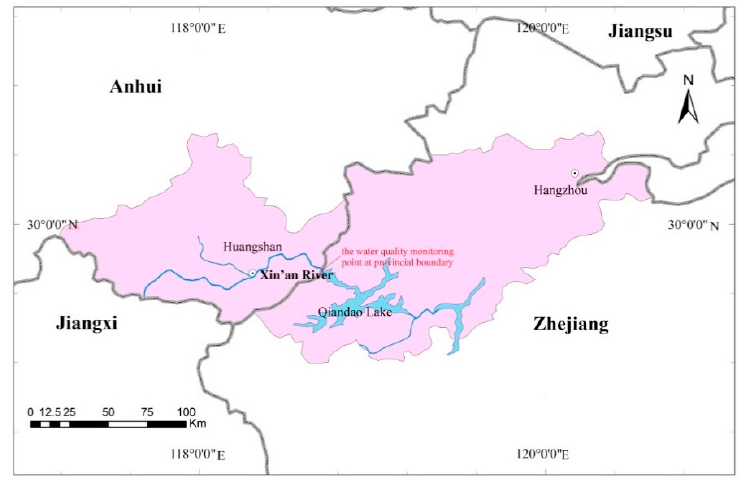
Figure 1. Location of Xin’an River. Table 1. Main contents of the three-round pilot agreement on the Xin’an River watershed ecological compensation scheme.